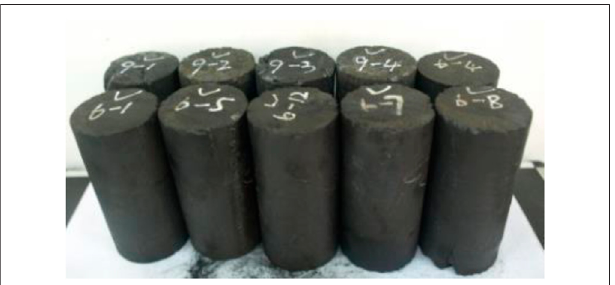
FIGURE 1 | Coal rock